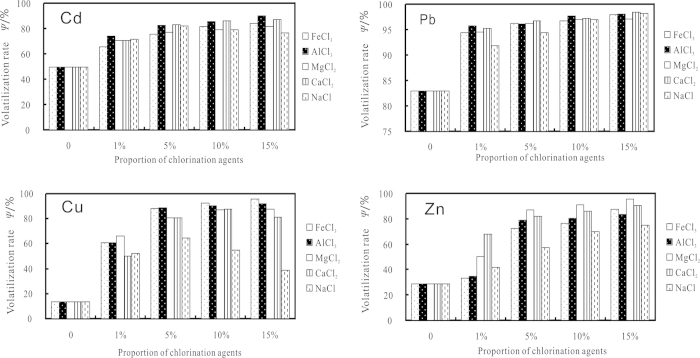
Effects of amount and type of chlorination agents on evaporation rate of heavy metals in fly ash (holding at 1000 °C for 60 min).